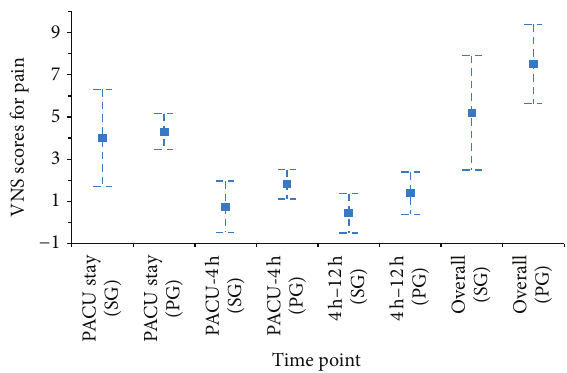
Figure 3: Morphine consumption during PACU stay and at 4 and 12h after surgery. 4 h–12h: from 4 to 12h after surgery; PACU: postanesthesia care unit; PACU-4 h: from PACU discharge up to 4 h after surgery; PG: placebo group; SG: S(+)-ketamine